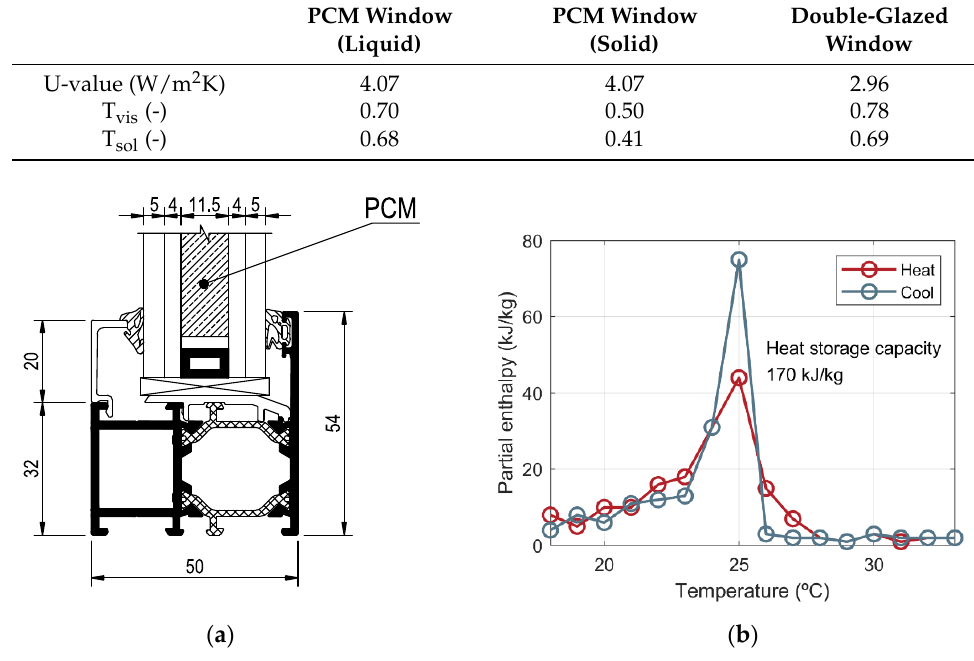
Figure 2. ( a ) window dimensions (mm); ( b ) partial enthalpy of paraffin RT25. Table 1. Thermophysical properties of the PCM window and double-glazed window.